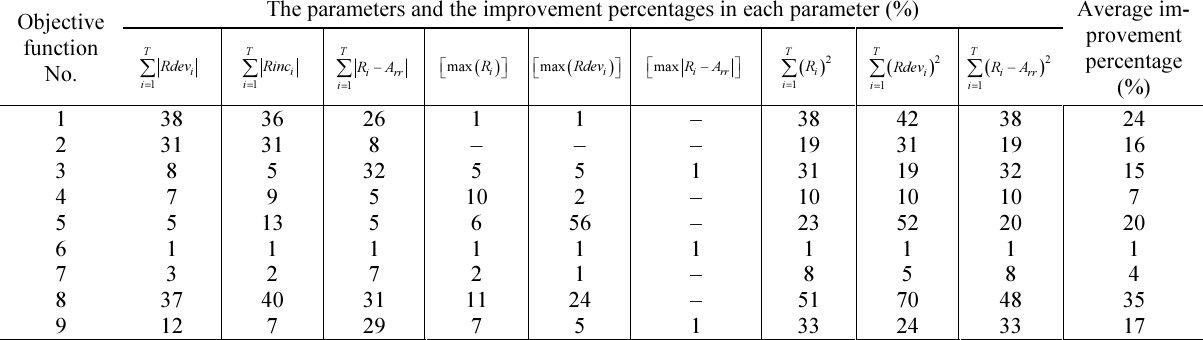
Table 4. Percentages of improvement (%) The parameters and the improvement percentages in each parameter (%) Objective function No.